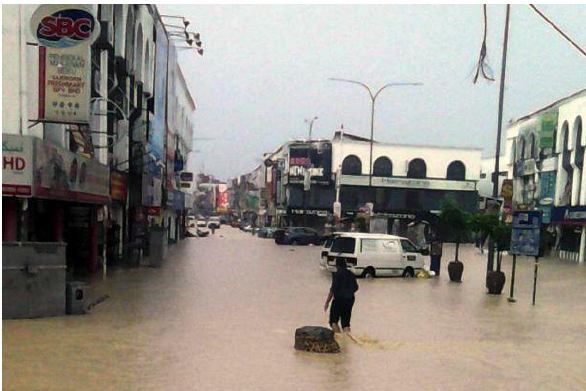
Figure 1: Image of flood in the commercial area of Kajang Town